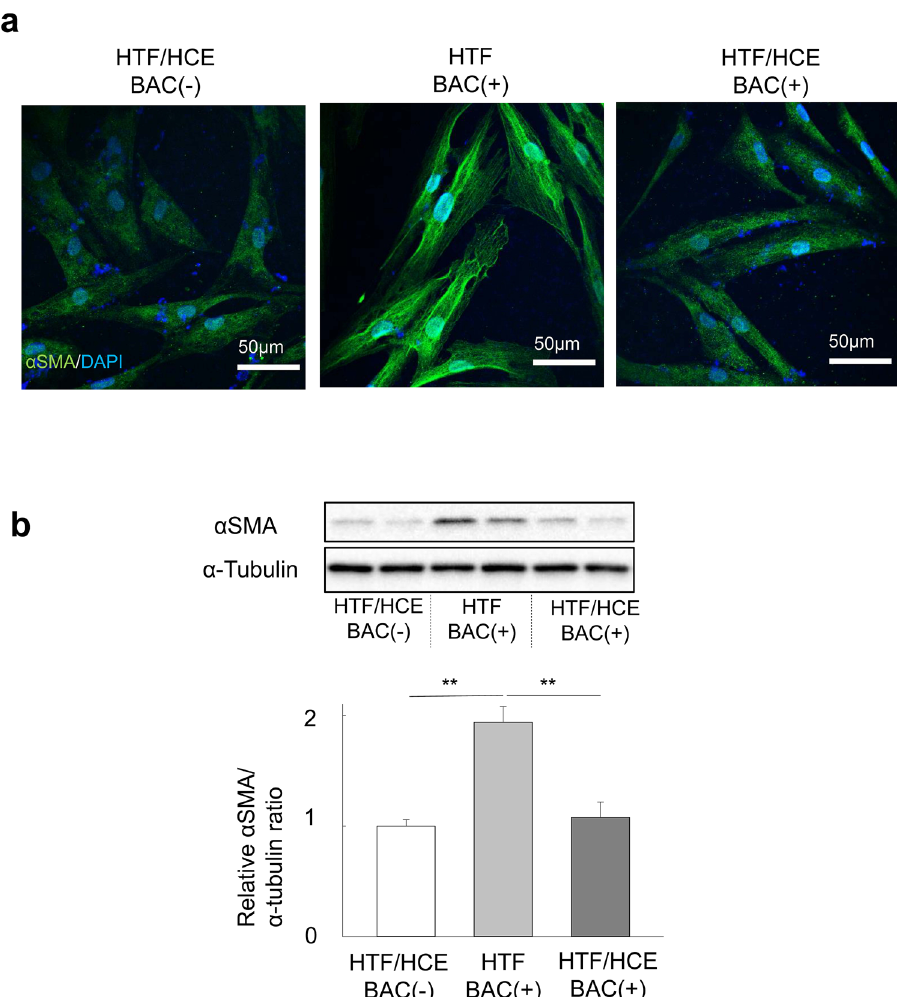
Figure 3. Effect of HCE cells on the BAC-induced transdifferentiation of HTFs into myofibroblasts in a coculture system. ( a ) HTFs cultured in hanging mesh inserts of six-well plates containing (or not) HCE cells were deprived of serum for 24 h, incubated in the absence or presence of BAC (5 × 10 −6 %) for 24 h, and then subjected to immunofluorescence staining with antibodies to αSMA (green). Nuclei were counterstained with DAPI (blue). Scale bars, 50 µm. ( b ) HTFs treated as in ( a ) were subjected to immunoblot analysis with antibodies to αSMA. Blots for duplicates of one representative experiment as well as quantitative data (means + s.e.m.) for the relative αSMA/α-tubulin band intensity ratio from five independent experiments are shown. ** p < 0.01 (Holm-Sidak post hoc test). Full-length blots are presented in Supplementary Fig.